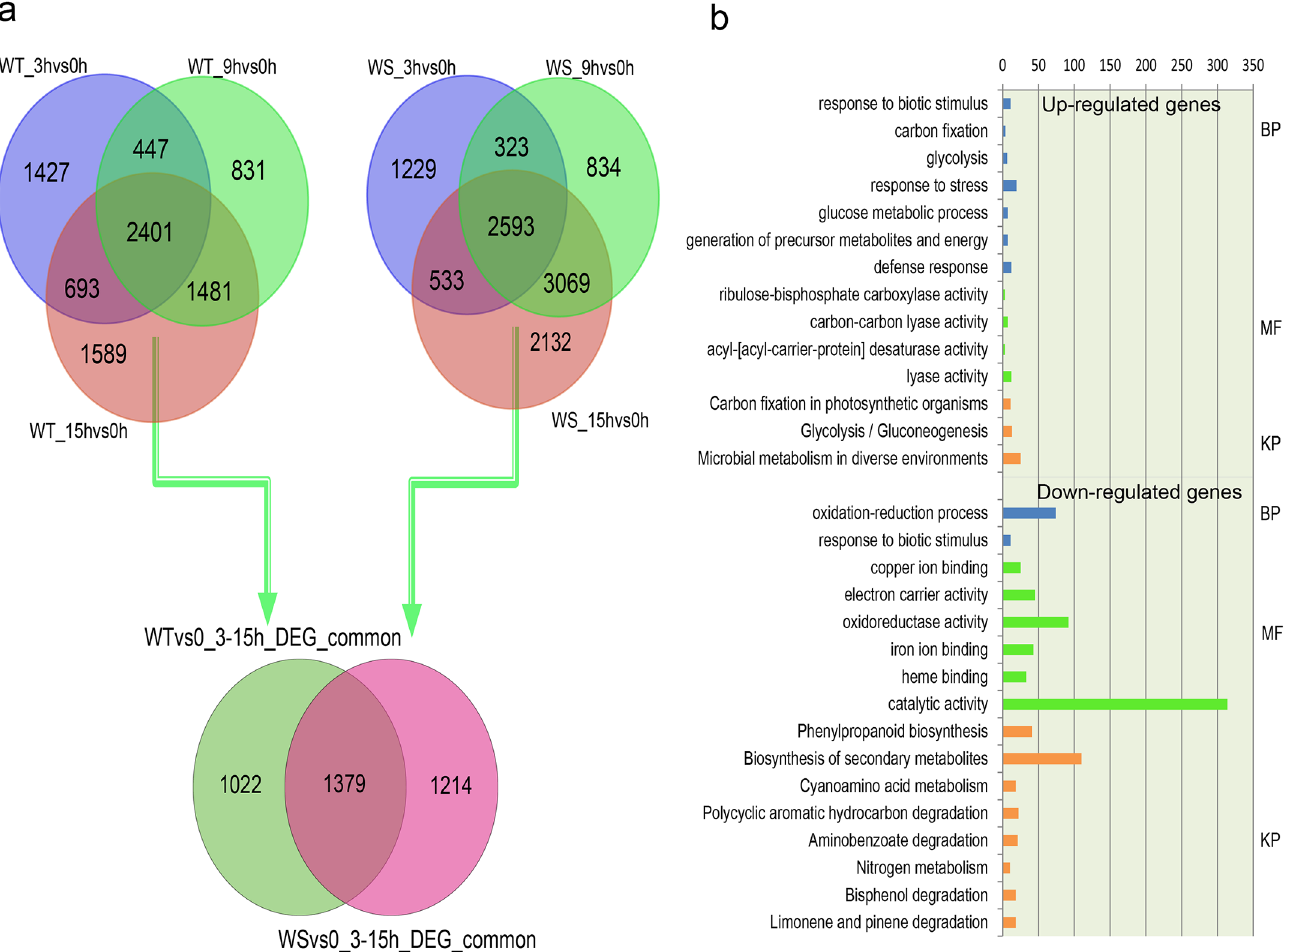
Fig 3. The core gene set responsible for waterlogging stress in sesame. (a) Venn diagrams of the special and unique DEGs at time points between 3 and 15 h under waterlogging conditions. (b) Enriched gene ontology (GO) and Kyoto Encyclopedia of Genes and Genomes (KEGG) pathway categories among the upregulated (up channel) and downregulated (down channel) genes in the core set.